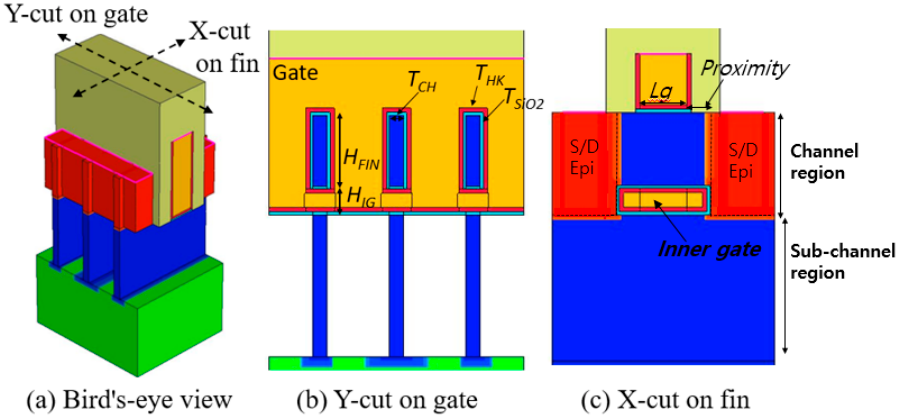
Figure 2. ( a ) Bird’s-eye and ( b , c ) cross-sectional views of FinFET-based vertical GAA-FinFET. The major geometric device parameters are noted in the figures. The device structure of the GAA-FinFET is similar to that of a FinFET device without an inner gate. The inner gate is placed on the bottom side of channel region. The length of the inner gate is defined as the gate length (L g ) plus the proximity. The height of the inner gate (H IG ) is 10